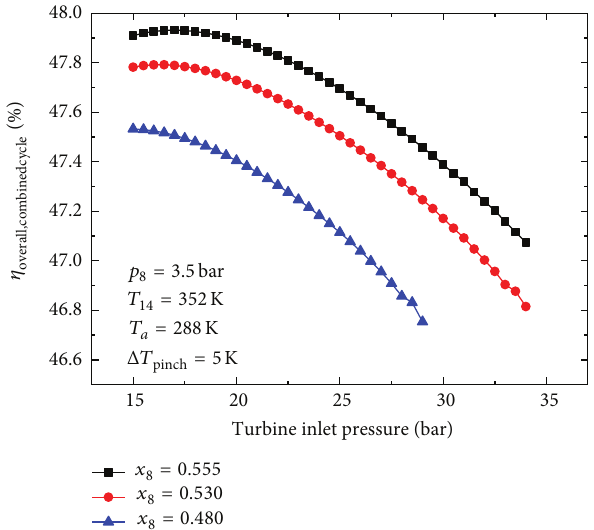
Figure 5: Variation of 𝐹(𝑋) of combined cycle with absorber pressure.